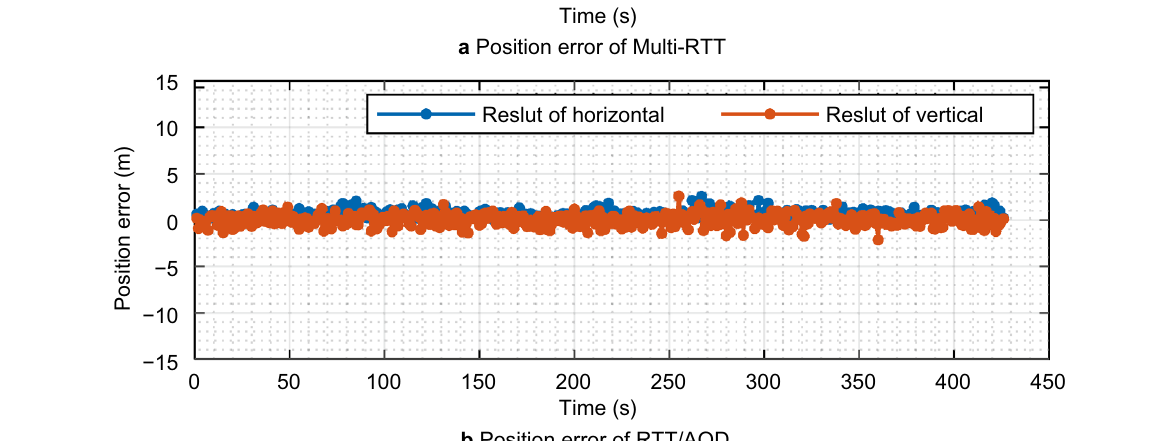
Fig. 11 Position error in a complex environment